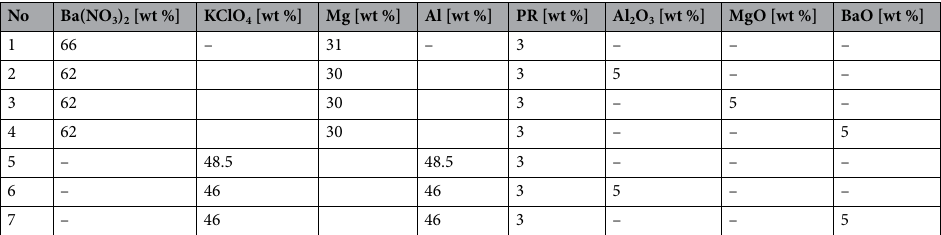
Table 2. Composition of samples by